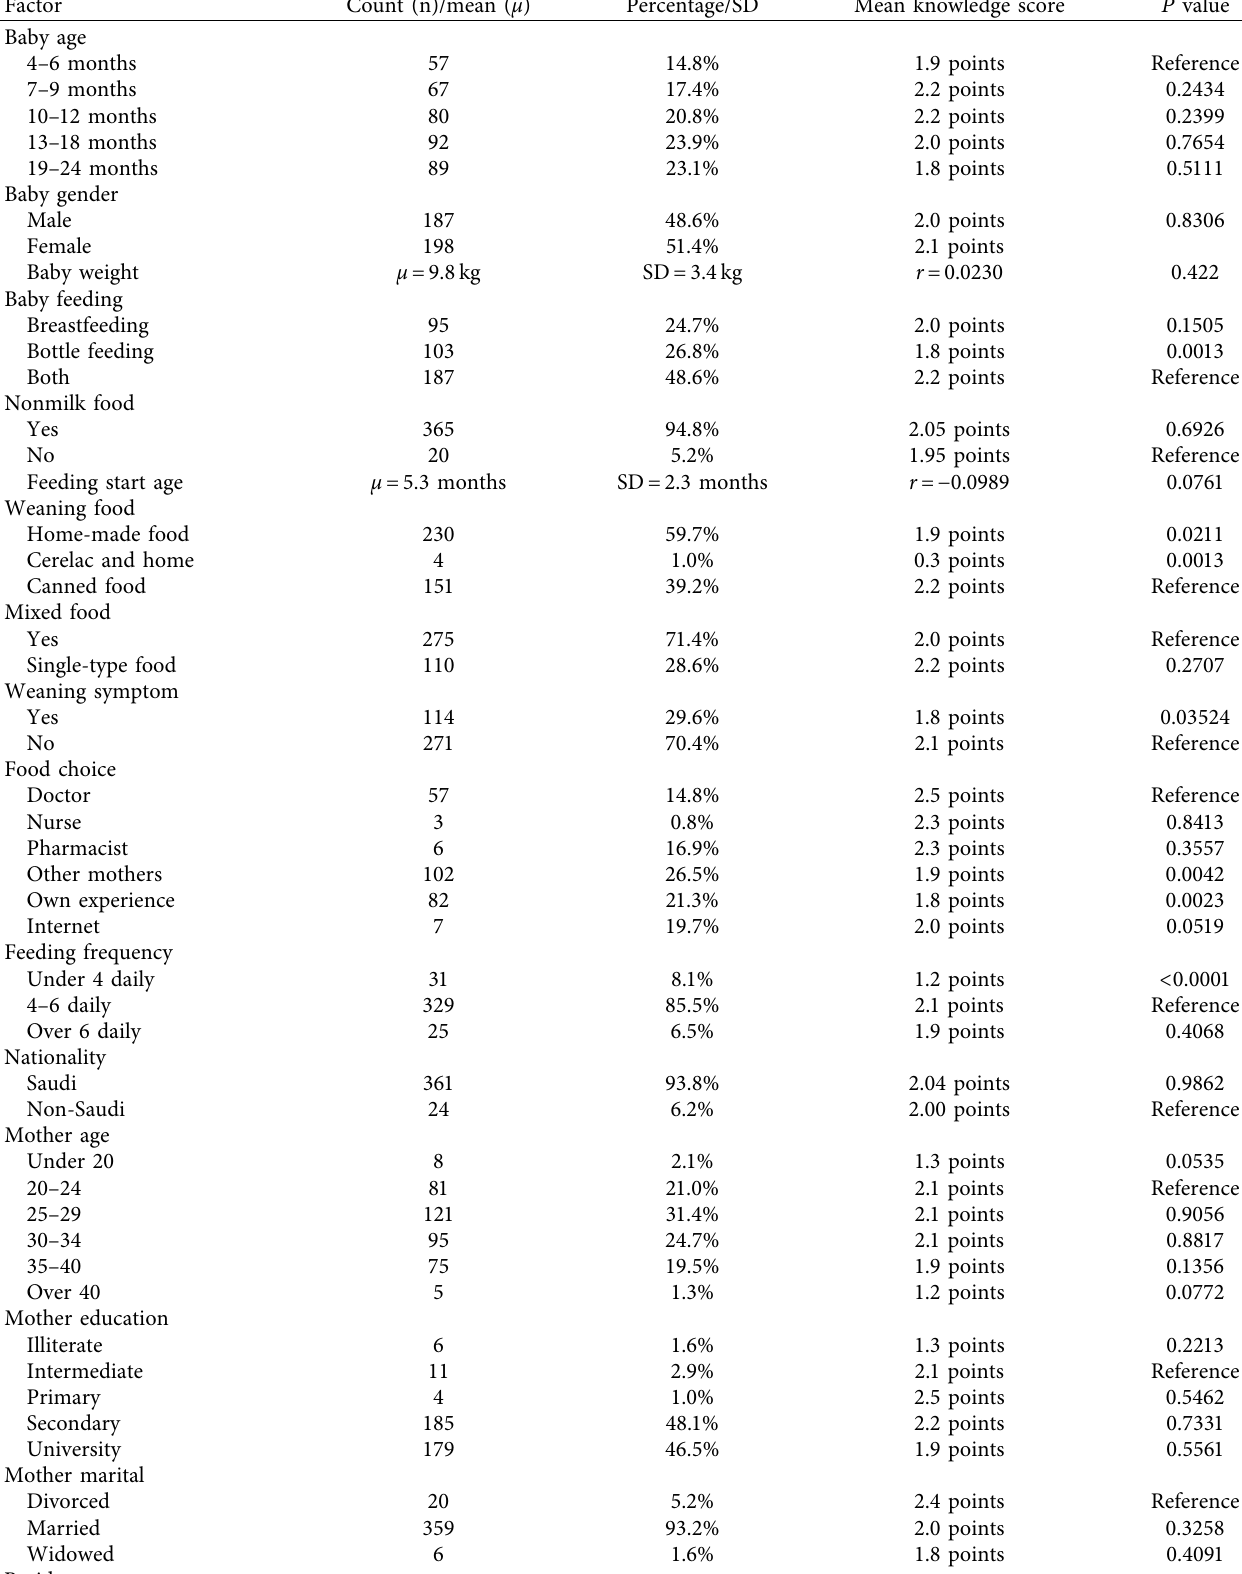
Table 1: Baseline demographics of mothers and unadjusted effect on knowledge